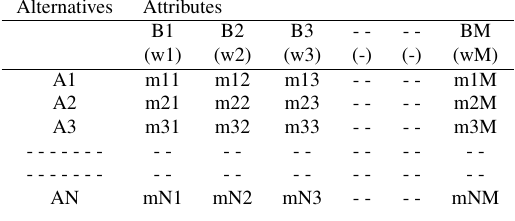
Table 1: Decision table in MADM methods